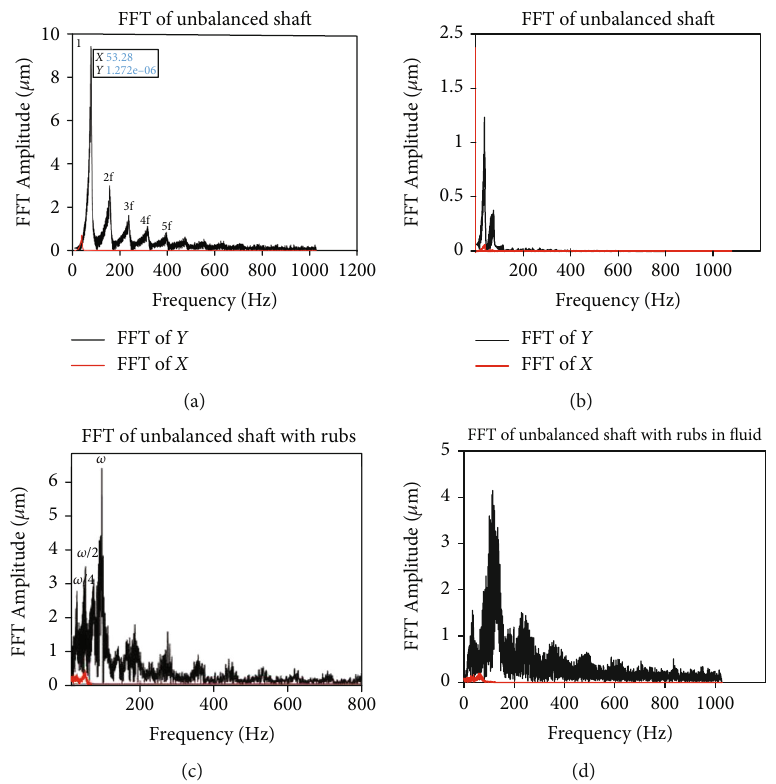
Figure 5: FTT spectrum of the vibration response in the X and Y direction.